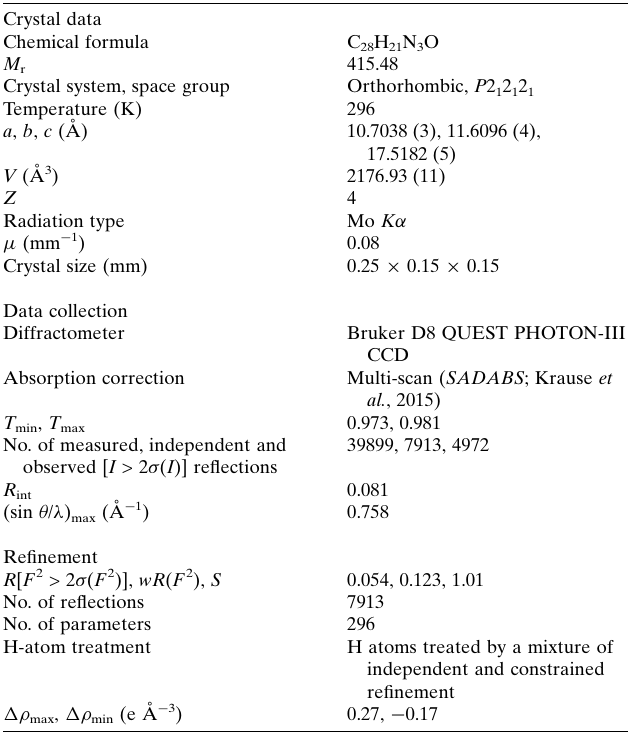
Table 4 Experimental details. Crystal data Chemical